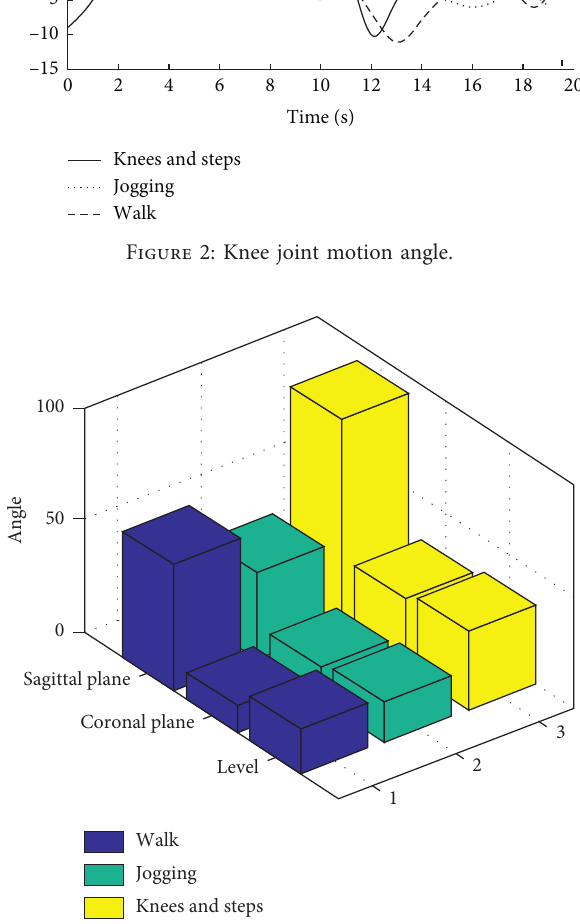
Figure 3: Knee motion amplitude.